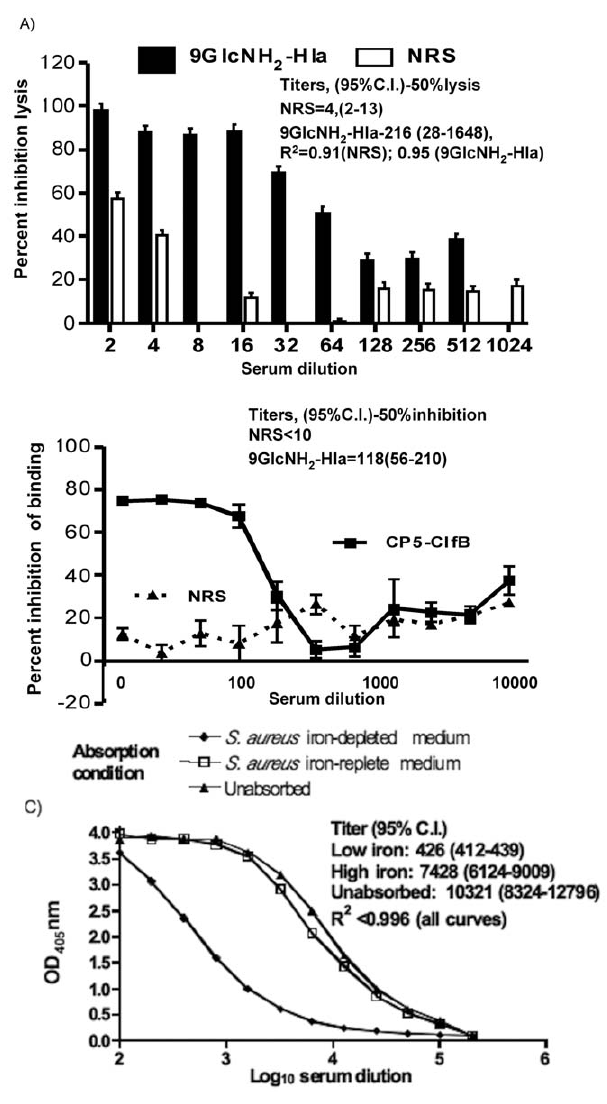
Figure 2. Effect of antisera to the carrier proteins Hla, ClfB and IsdB on their biological activities. (a) Rabbit antisera raised to 9GlcNH 2 -Hla inhibited lysis of rabbit red blood cells (RRBC) due to S. aureus hemolysin A. Percent hemolysis was calculated using as the denominator the haemoglobin absorbance at 475 nm obtained following lysis of control RBC in 1% Triton X-100. Lack of overlap in the 95% C.I. between the 50% lysis titers indicates difference significant at P , 0.05. Bars represent mean of triplicates. (b) Inhibition of binding of S. aureus Newman D clfA due to antibody raised to CP5-ClfB to immobilized fibrinogen. Percent inhibition of binding was calculated using as the denominator the OD 650 nm values obtained in the control with no serum. Lack of overlap in the 95% C.I. between the 50% lysis inhibition titers indicates difference significant at P , 0.05. Lines represent mean of triplicates. (c) ELISA titers to purified IsdB protein in intact antisera or antisera absorbed with S. aureus cells grown in an iron depleted medium to induce IsdB, or in an iron-replete medium to repress IsdB synthesis. Lines represent mean of duplicates.